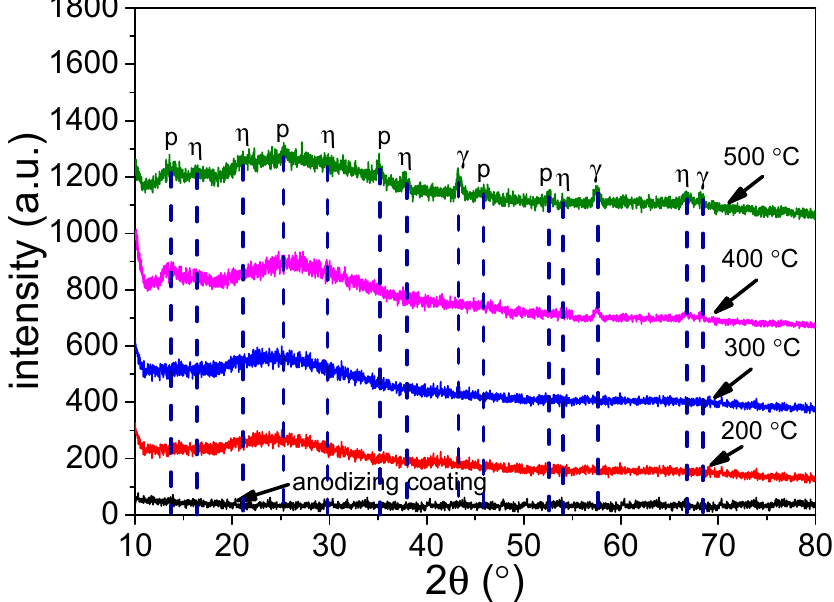
Figure 4. XRD spectra of anodic coating before and after being treated by hydro-thermal technology at 200 °C, 300 °C, 400 °C and 500 °C.